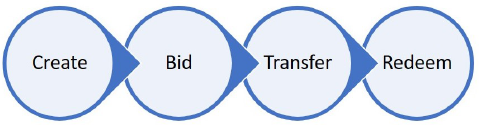
Figure 2. Operations of the token.